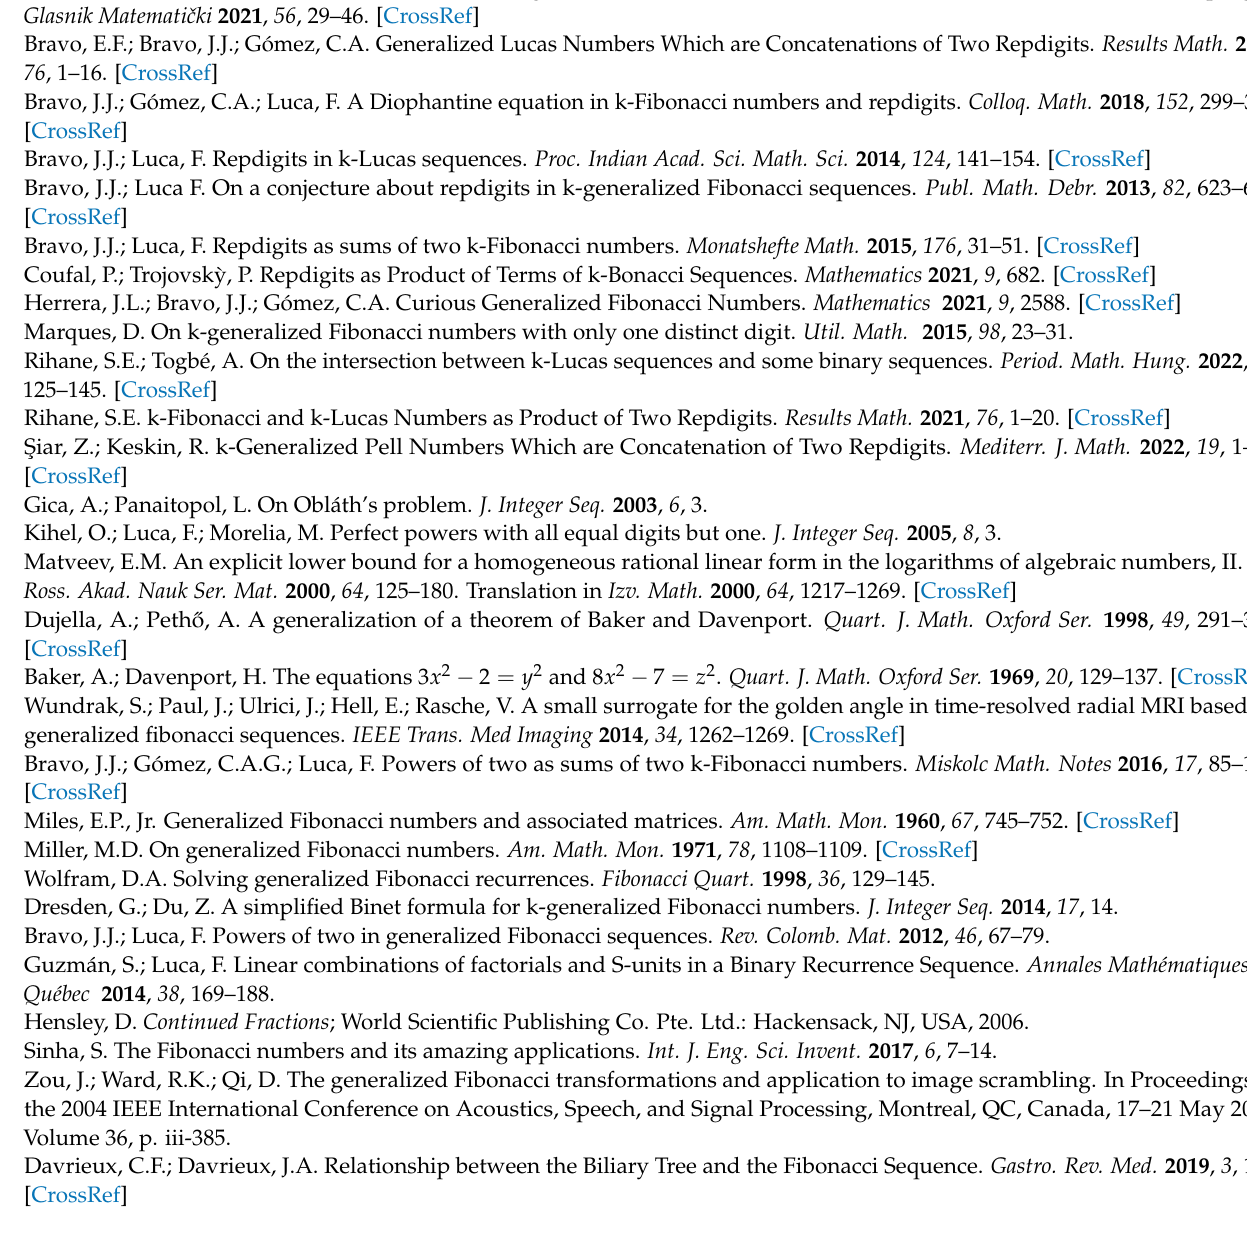
Table A1. The First 15 Elements of the Sequence F